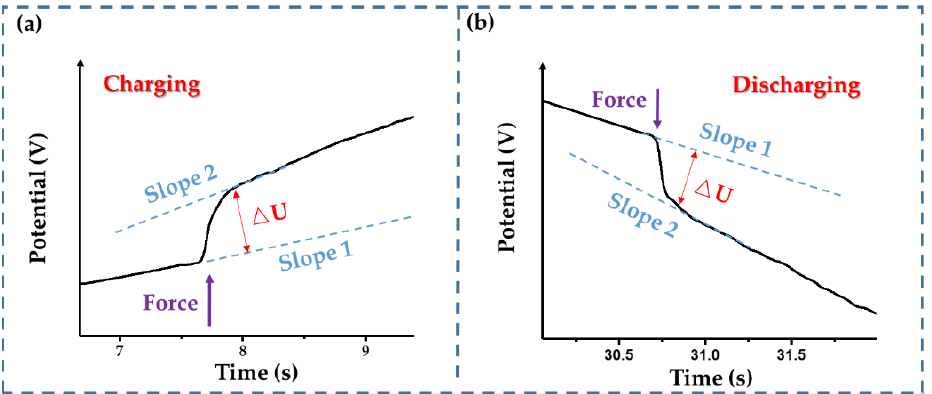
Figure 13. The potential changes while experiencing a step force during ( a ) the charging process and ( b ) the discharging process.